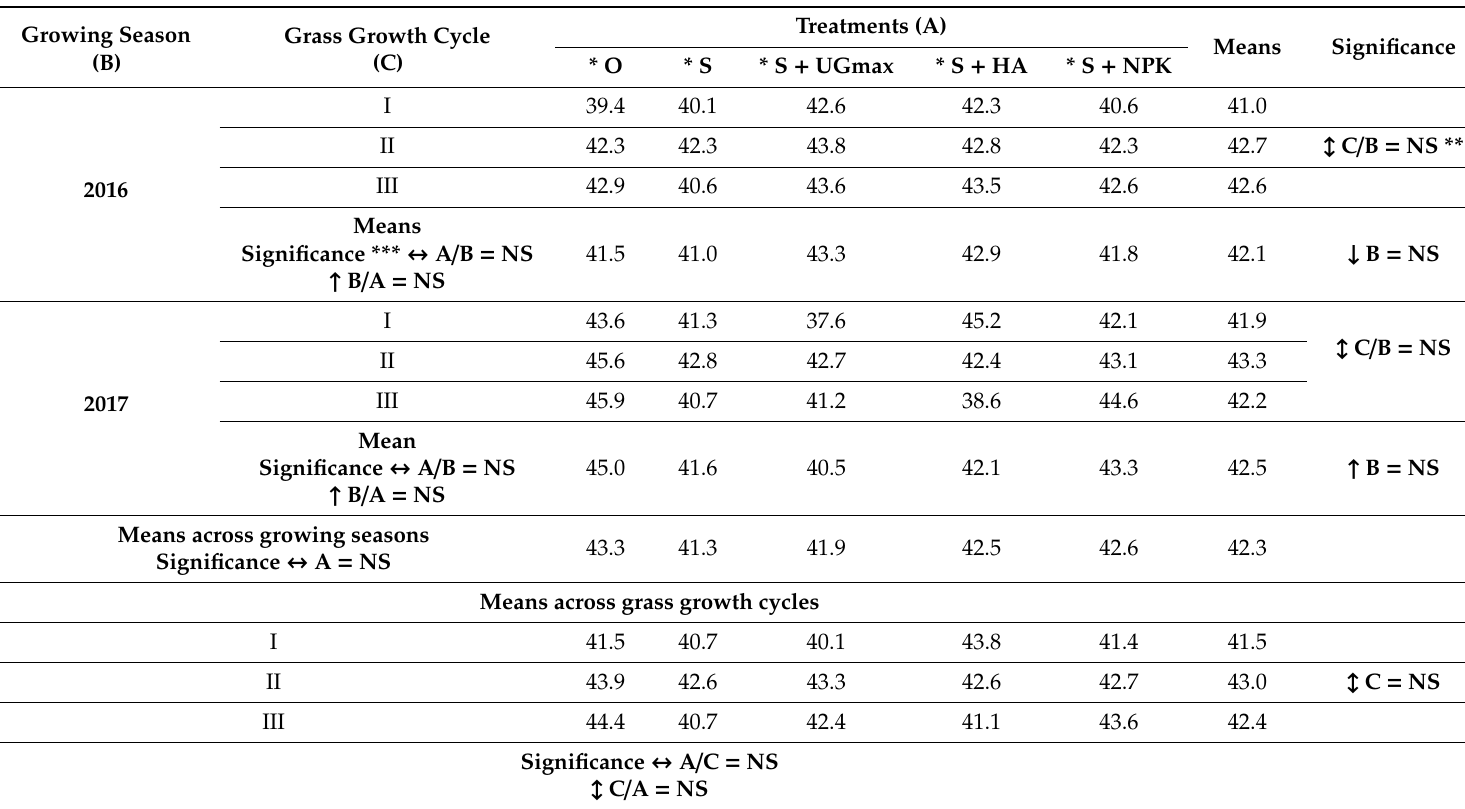
Table 6. The e ff ect of treatments on mean acid detergent lignin (ADL) content in Festulolium braunii dry matter across grass growth cycles and growing seasons (g · kg − 1 ). Growing